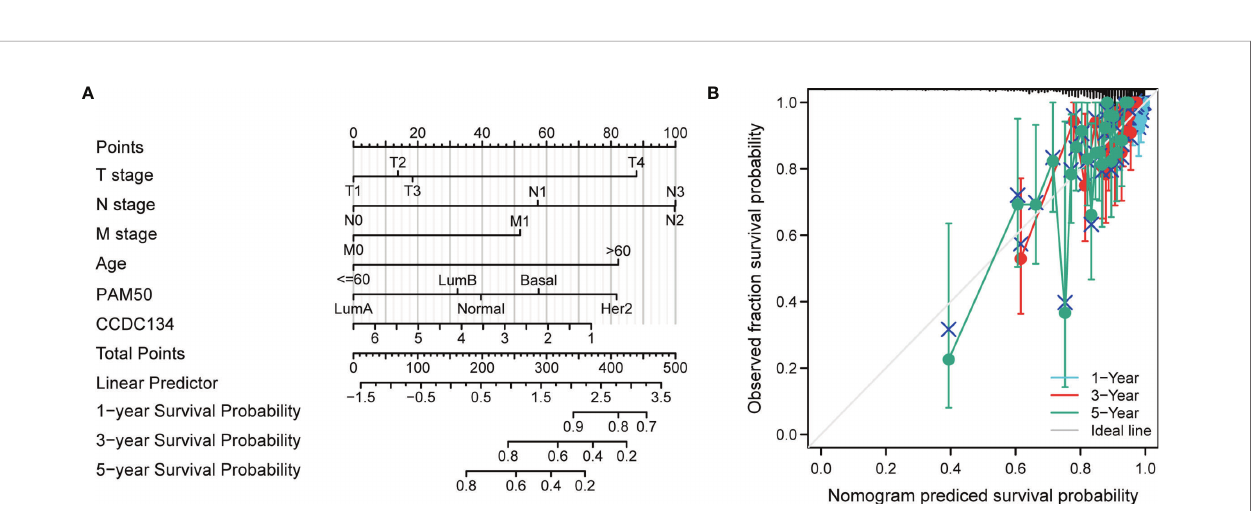
FIGURE 5 | ROC and Kaplan-Meier curves of CCDC134. (A) THE ROC curve showed that the AUC value of CCDC134 was 0.663. (B) Kaplan-Meier survival curve showed that the RFS of breast cancer patients with high CCDC134 mRNA expression was shorter (57.27 months vs. 36.96 months) than that of breast cancer patients with low CCDC134 mRNA expression. P = 2.0